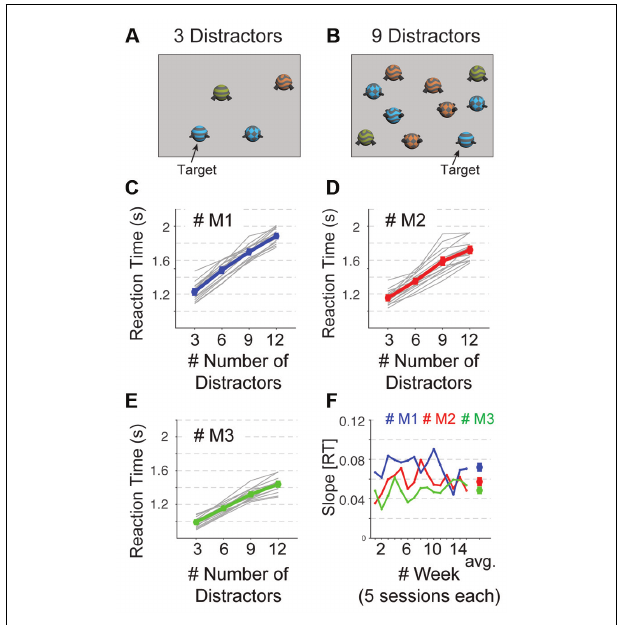
FIGURE 3 | Visual search performance. (A,B) Visual display with a target object and 3 (A) and 9 (B) distractor objects that shared features with the target. (C–E) Visual search reaction times (Y-axis) for 3–12 distractors (x-axis) in each of 15 weeks (gray lines) and on average (colored line) for monkey M1 (C) , M2 (D) , and M3 (E) . (F) The regression slope or the reaction time increase with distractors for each monkey (in color) over 15 weeks. The rightmost data point is the average set size effect for each monkey. Error bars are